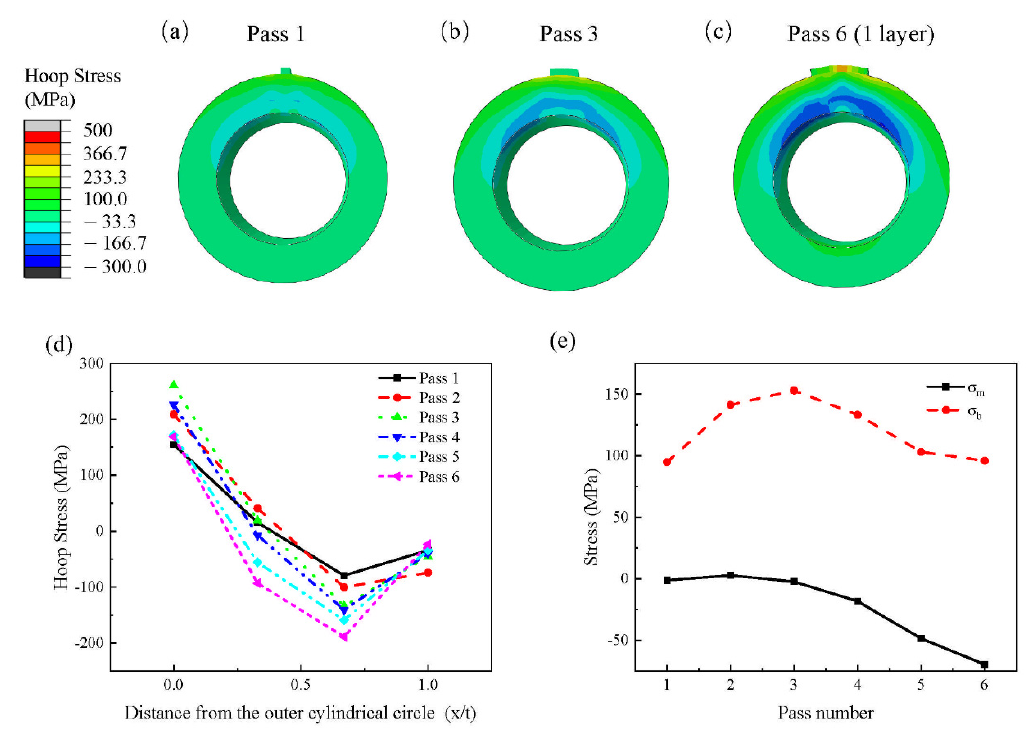
Figure 13. Hoop residual stress distribution at mid-length of the weld overlay joint with outside-to-center welding sequence after ( a ) pass 1, ( b ) pass 3, and ( c ) pass 6 (1 layer), respectively; ( d ) distribution of hoop residual stress in the through-thickness direction; and ( e ) evolution of decomposed component of hoop residual stress distribution when overlaying the 1st layer.